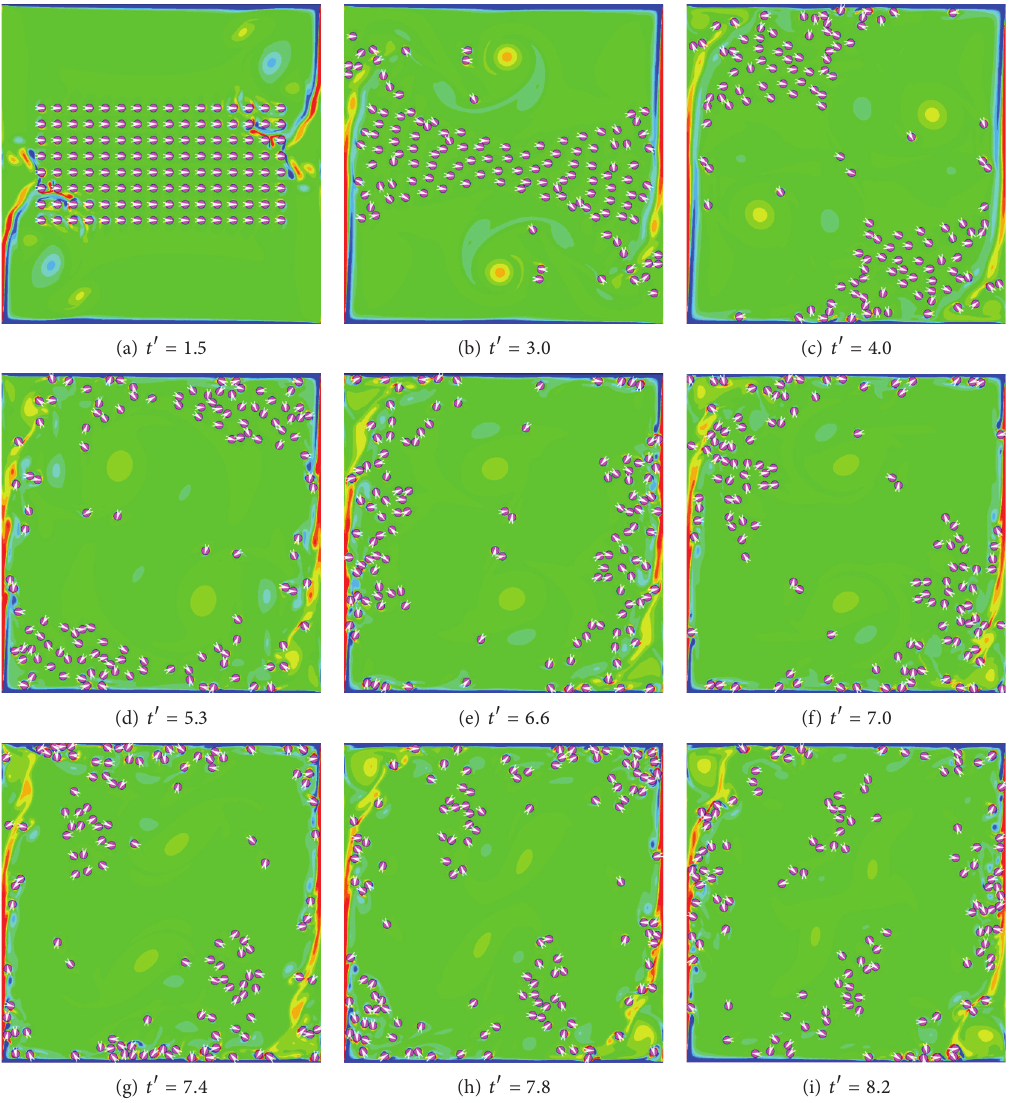
Figure 5: Vorticity contours when 𝑈 0 = 0.3